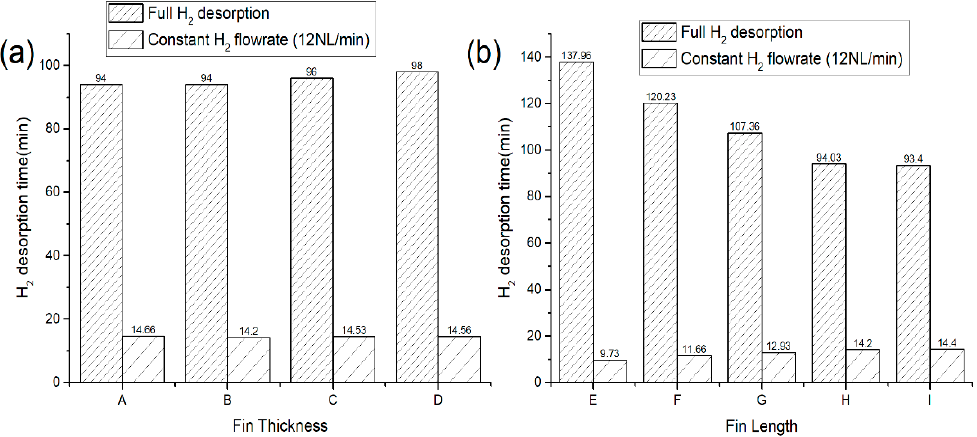
Figure 7. ( a ) effect of fin thickness on the dehydrogenation time (A: δ fin = 0.001 m, B: δ fin = 0.002 m, C: δ fin = 0.003 m, D: δ fin = 0.0035 m), ( b ) effect of fin length on the dehydrogenation time (E: L f =0.015 m, F: L f =0.02 m, G: L f =0.025 m, H: L f =0.035 m, I: L f = 0.038 m).